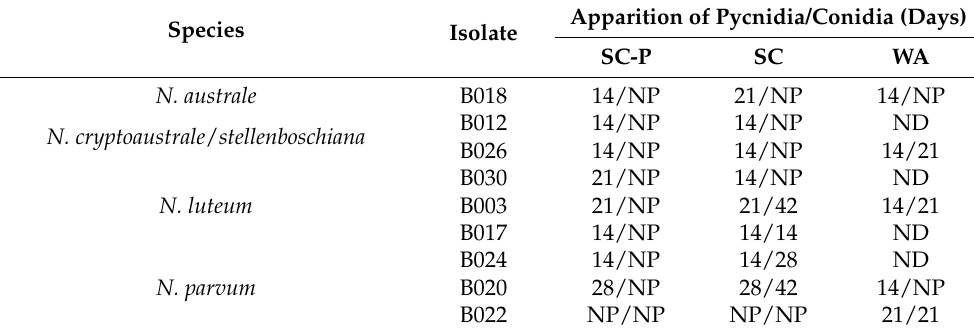
Table 3. Production of pycnidia/conidia by Neofusicoccum isolates.